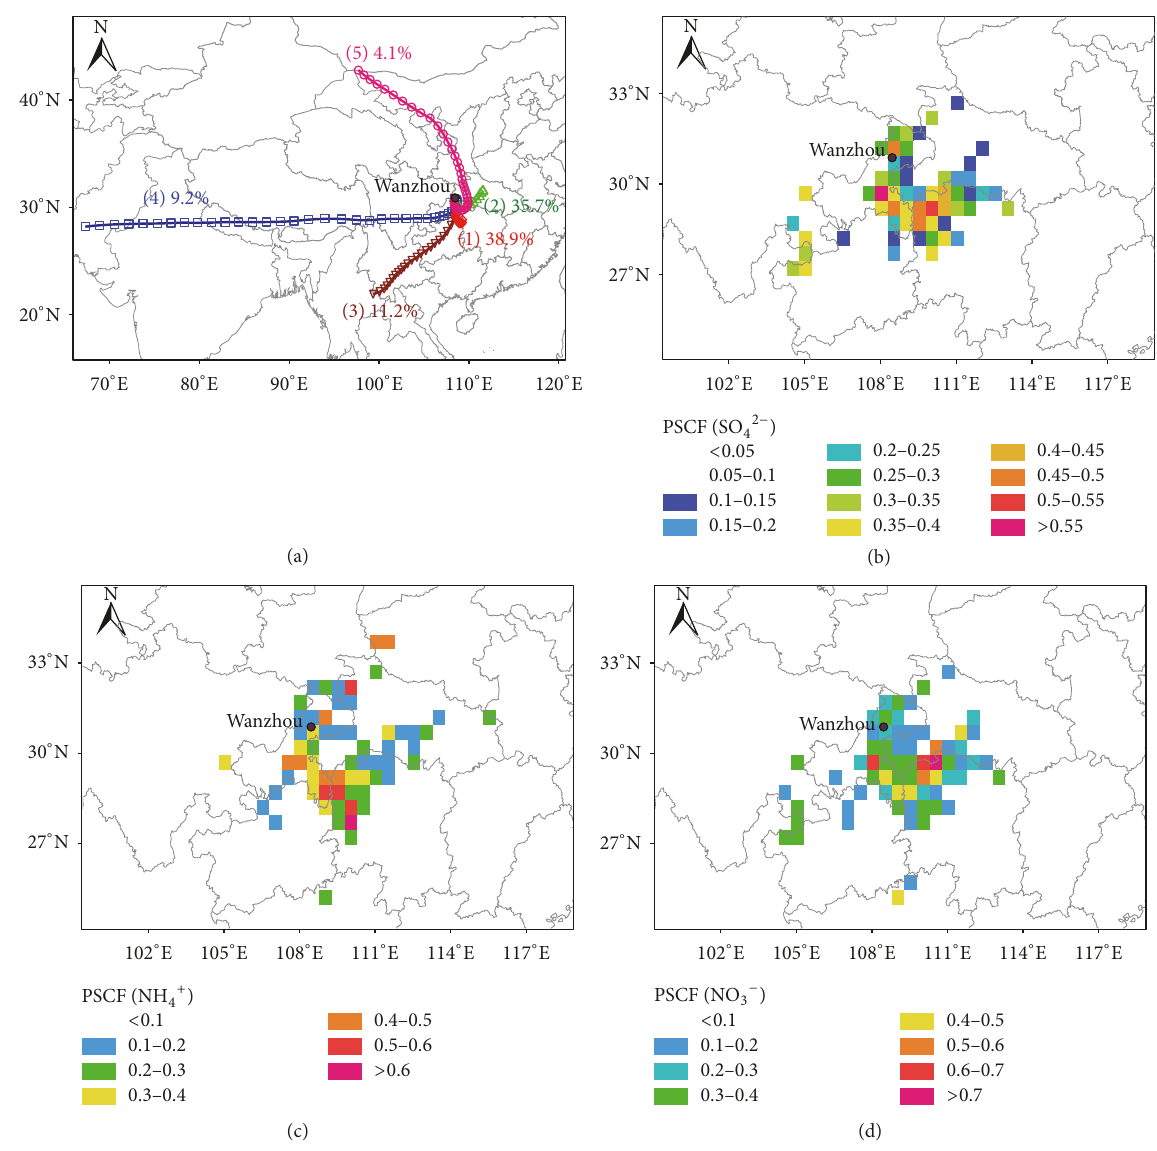
Figure 6: Cluster analysis (a) and potential source areas for SO 4 2− (b), NH 4 + , (c) and NO 3 − (d) in